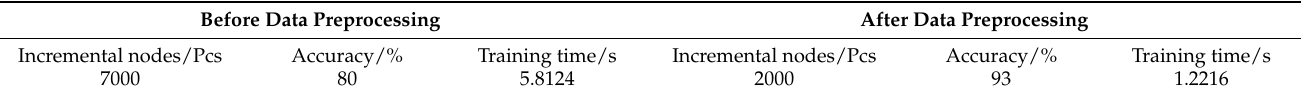
Table 4. Comparison of prediction results before and after data preprocessing.